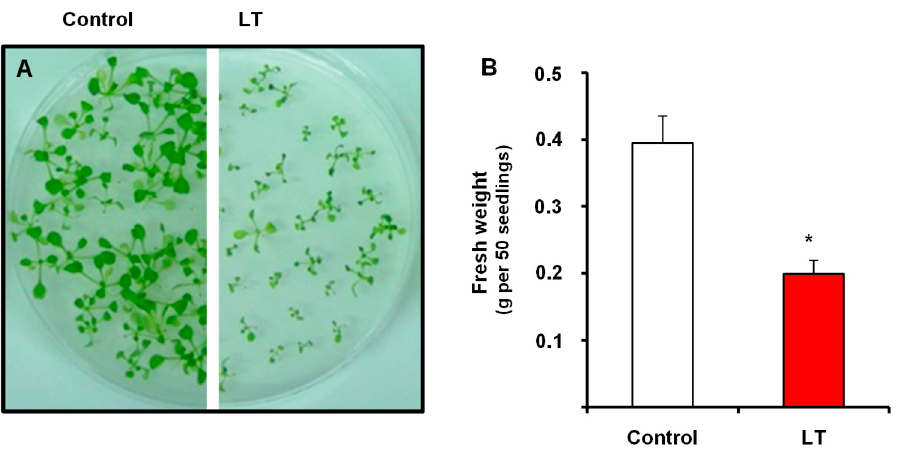
Figure 1. ( A ) Appearance and ( B ) fresh weight of the 14-day-old Arabidopsis seedlings grown in MS medium subjected to low temperature (LT) for the last 48 h. The results are the mean of at least three different experiments + SEM. For each experiment, 200 seedlings were used. * Differences in relation to the control values were significant at p < 0.05.